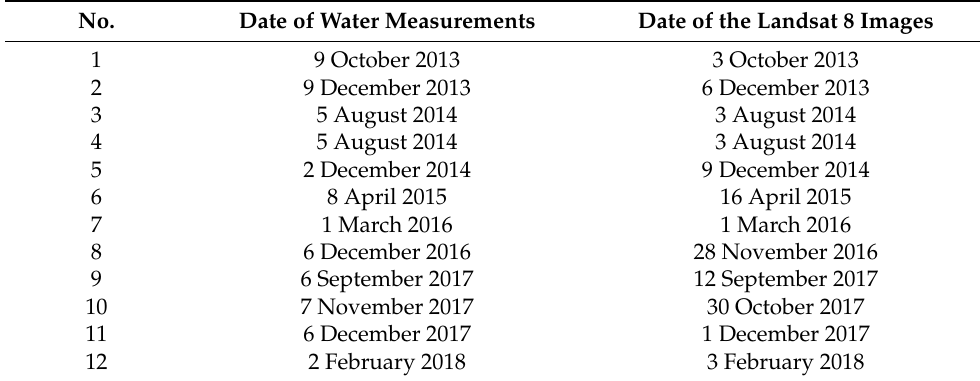
Table 1. The date of water measurements and the acquisition date of the Landsat 8 images.